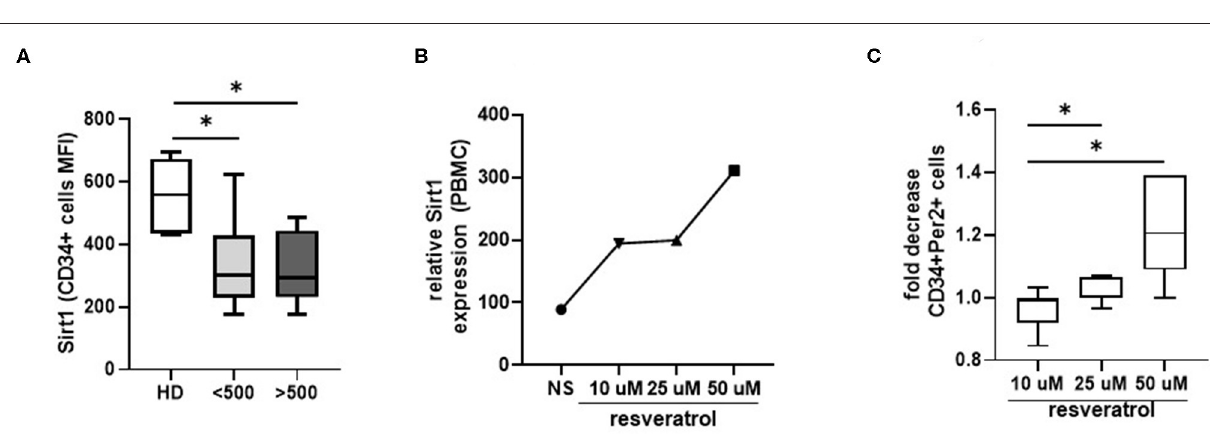
FIGURE 4 | Sirt1 modulation. (A) Histograms show the median and range of Sirt1 MFI in CD34 + cells from HD and HIV-infected patients. Mann–Whitney test, * p < 0.05; HD, healthy donors ( n = 7), < 500, HIV + patients with CD4T cells count < 500 ( n = 8), > 500, HIV + patients with CD4T cells count > 500 ( n = 7). (B) Relative Sirt1 expression after 24h of whole blood stimulation with resveratrol (50, 25, and 10 µ M concentration). The data refer to the mean of 2 pool (each pool consists of 4 samples). (C) Histograms show the median and range of the fold of decrease of CD34 + Per2 + cells percentage after 24h of whole blood stimulation with resveratrol (50, 25, and 10 µ M concentration). Wilcoxon matched-pairs signed rank test, * p <